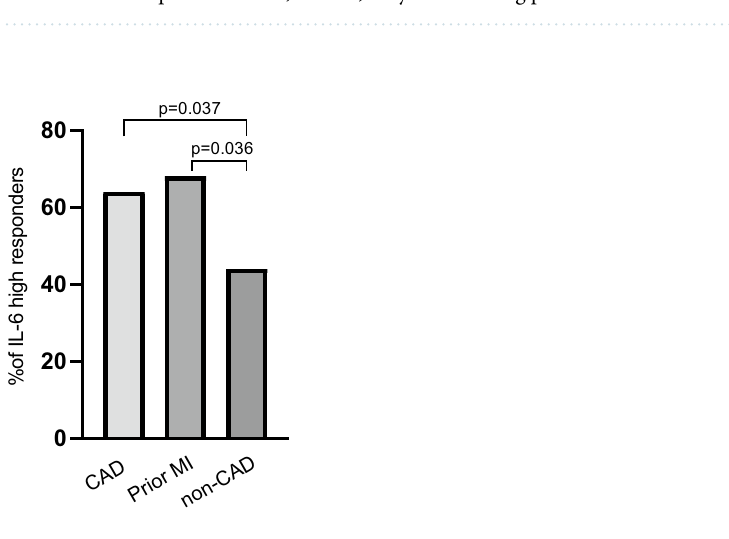
Figure 2. The proportions (%) of IL-6 high responders among patients with documented CAD, defined as a history of prior MI and/or coronary revascularization and/or a myocardial perfusion deficit (n = 36), in patients with a history of prior MI (n = 25) and in patients with no signs of CAD, i.e. no history of prior CAD events and normal SPECT MPI (n =